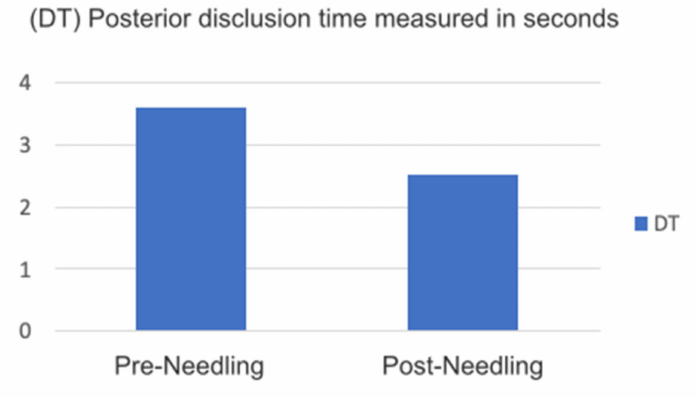
Figure 9. Graph DT posterior disclusion time measured in